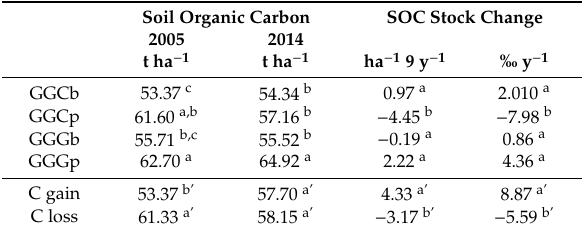
Table 6. Predicted SOC for the points, where pedological parameters (Table 5) were measured. Lowercase letter is statistical significance of the two-way ANOVA and Tukey’s HSD post-hoc test: a, b and c for management treatments and a’ and b’ for C gain or loss points,